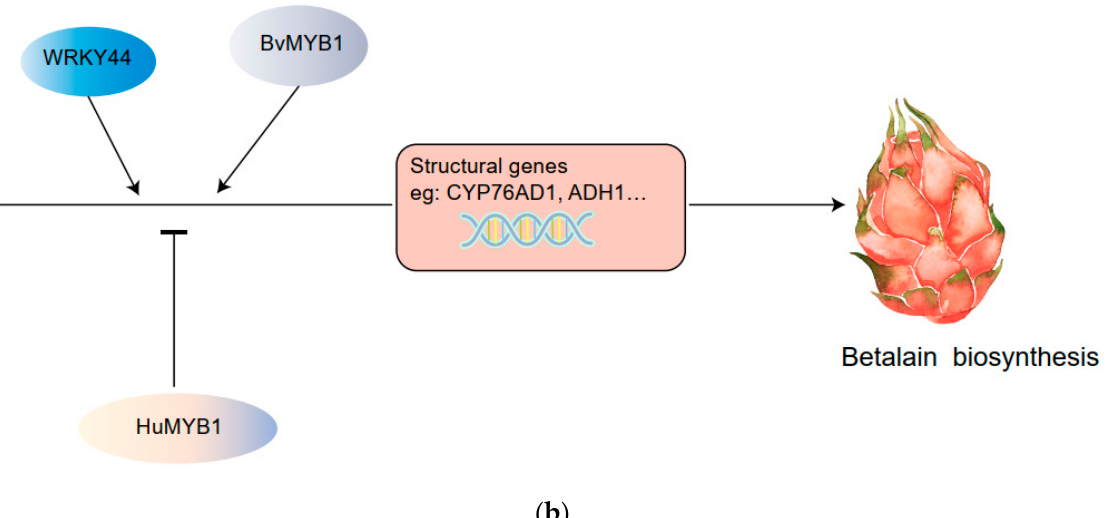
Figure 4. Betalain biosynthesis pathway. ( a ) Betalain biosynthesis pathway in plants. ( b ) The transcription of structural betalain biosynthesis genes is regulated by MYB or other TFs. 4,5DOD: DOPA-4,5-dioxygenase; DOPA-OX: DOPA oxidase; S: spontaneous conversion; Tyh-OHase: tyrosine hydroxylase.